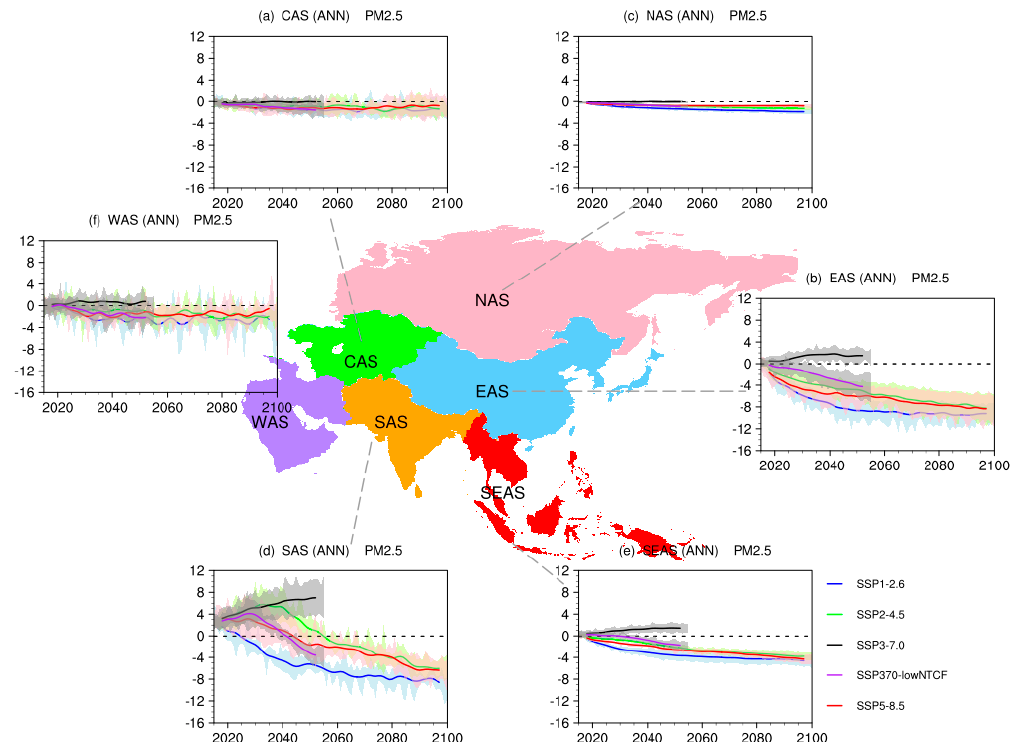
Figure 4. Time evolutions of annual mean surface PM 2.5 concentrations (units: µg/m 3 ) over Asia under SSP1-2.6 (red curves), SSP2-4.5 (green curves), SSP3-7.0 (black curves), SSP370-lowNTCF (purple curves), and SSP5-8.5 (red curves), relative to 1995–2014, where shadings indicate model uncertainty range (1 standard deviation of the simulations).